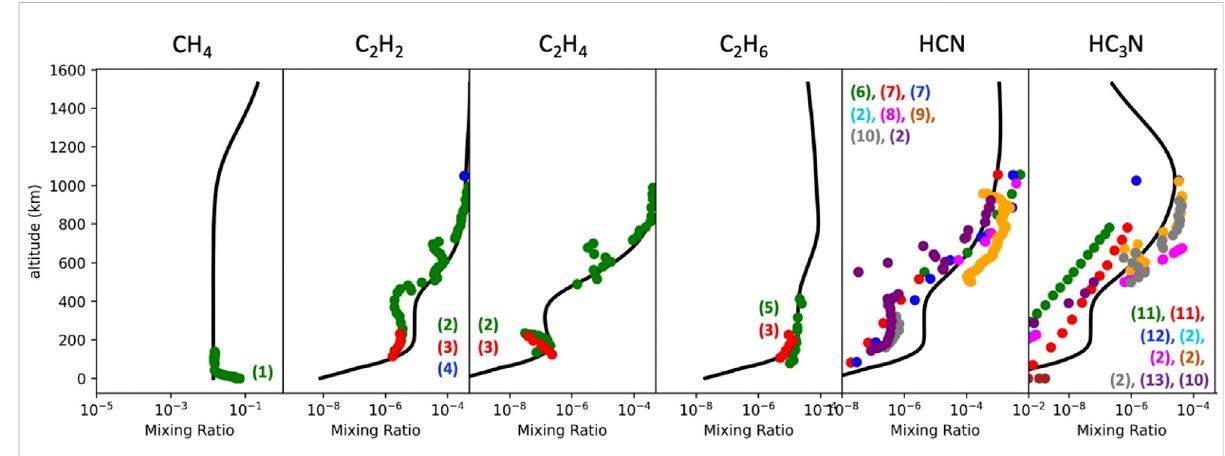
FIGURE 14 Mixing ratio pro fi les of CH 4 , C 2 H 2 , C 2 H 4 , C 2 H 6 , HCN, and HC 3 N at Titan. Model results are in black and overplotted dots show a comparison to recentobservationsintheliterature:(1)Niemannetal.(2010);(2)Koskinenetal.(2011);(3)Nixonetal.(2013);(4)Mageeetal.(2009);(5)Lombardoet al.(2019);(6)Adrianietal.(2011);(7)Kimetal.(2005);(8)Shemanskyetal.(2005);(9)Vervacketal.(2004);(10)Vinatieretal.(2010);(11)Cordineretal. (2014); (12) Cui et al. (2009); (13) Marten et al.